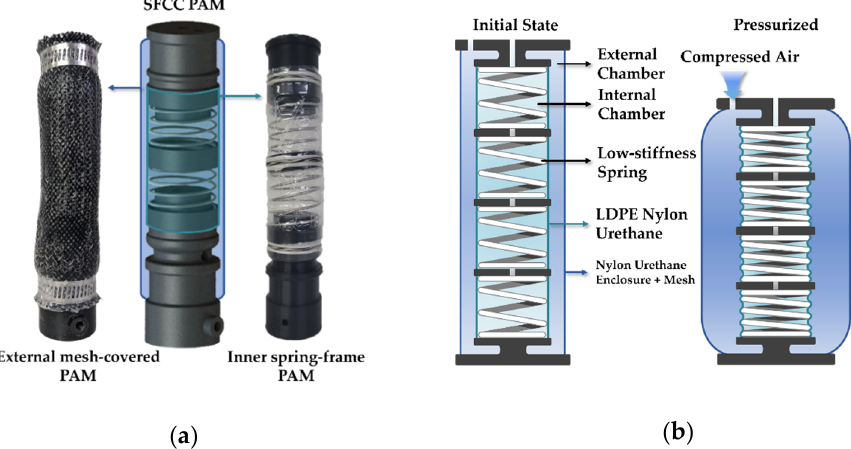
Figure 1. ( a ) An illustration of the external and internal structure of the SFCCM PAM. ( b ) A conceptual representation of the SFCCM PAM. While the compressed air pressurizes the external chamber, the air in the internal chamber adjusts exhaust to the atmospheric level by exhausting through the independent air holes.